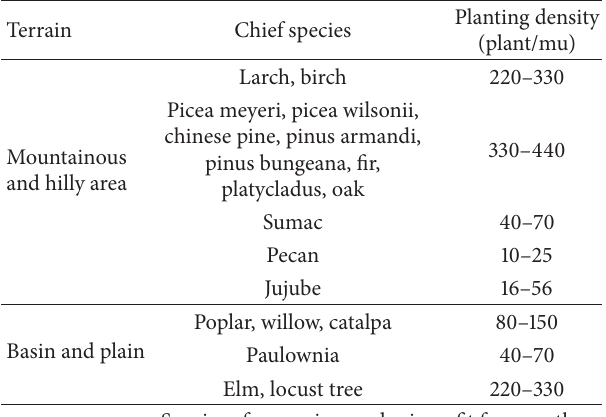
Table 3: The suitable tree species and the standard of planting density in